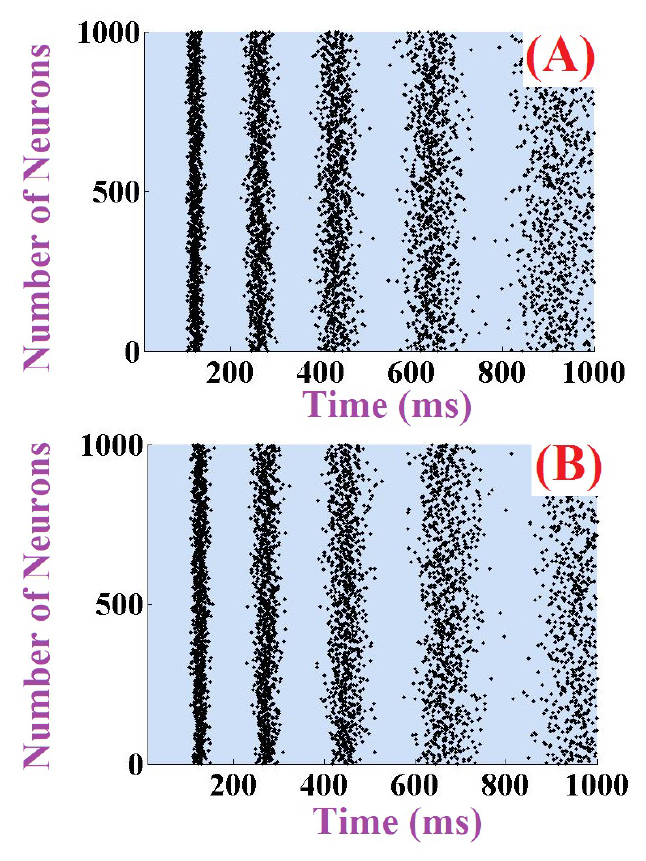
Figure 13. Raster plots for tonic spiking patterns in terms of 1000 randomly connected neurons. ( A ) Tonic original neurons. ( B ) Tonic proposed